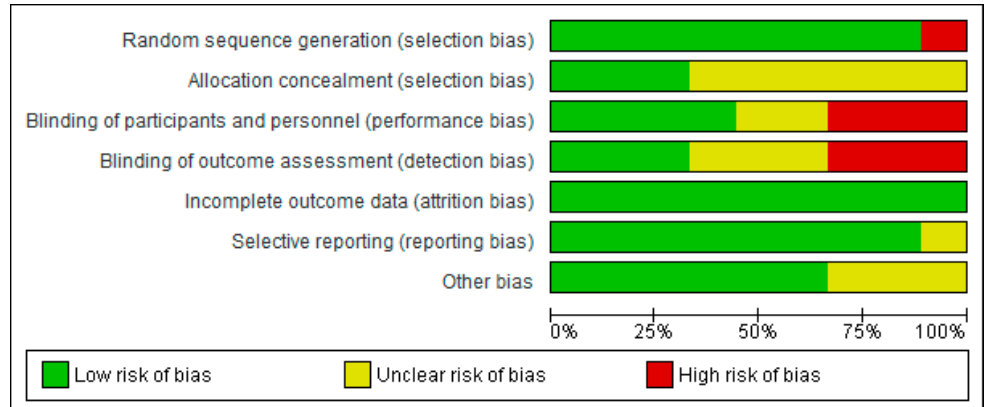
Figure 1. PRISMA flowchart of the literature search process.